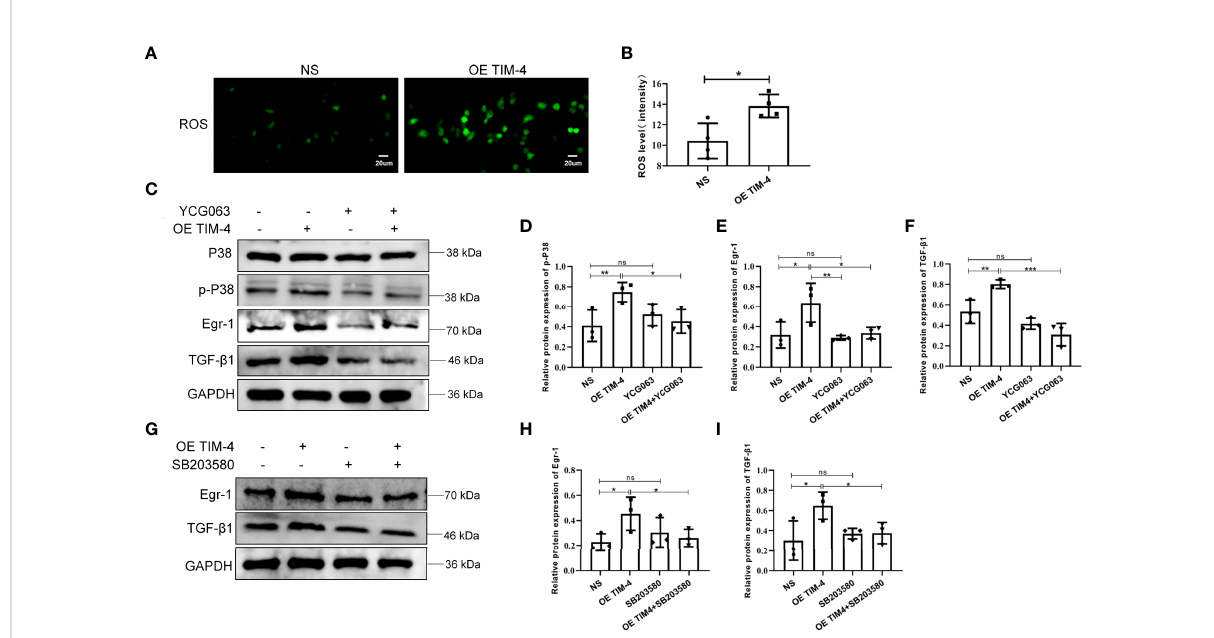
FIGURE 7 The ROS/p38 MAPK/Egr-1 pathway participates in the process of TIM-4-mediated TGF- b 1 upregulation in macrophages. (A, B) ROS levels in OE TIM-4 THP-1 cells and control cells were measured by the fl uorescence probe DCFH-DA; (C-F) Normal or OE TIM-4 THP-1 cells were treated with or without a ROS inhibitor (YCG063), and then the expression of Egr-1, phospho-p38, and TGF- b 1 were analyzed by Western blot analysis; (G-I) To con fi rm the role of p38 MAPK in the ROS-dependent signaling pathway, normal or OE TIM-4 THP-1 cells were treated with a p38 inhibitor (SB203580). Then the expression of Egr-1 and TGF- b 1 were analyzed by Western blot analysis. The intensity values of the bands were normalized to GAPDH expression. For each group, n=3; Representative immuno fl uorescence images are shown at 400× magni fi cation. Bars show the mean ± SD. *P<0.05, **P<0.01,***P<0.001. ns, no signi fi